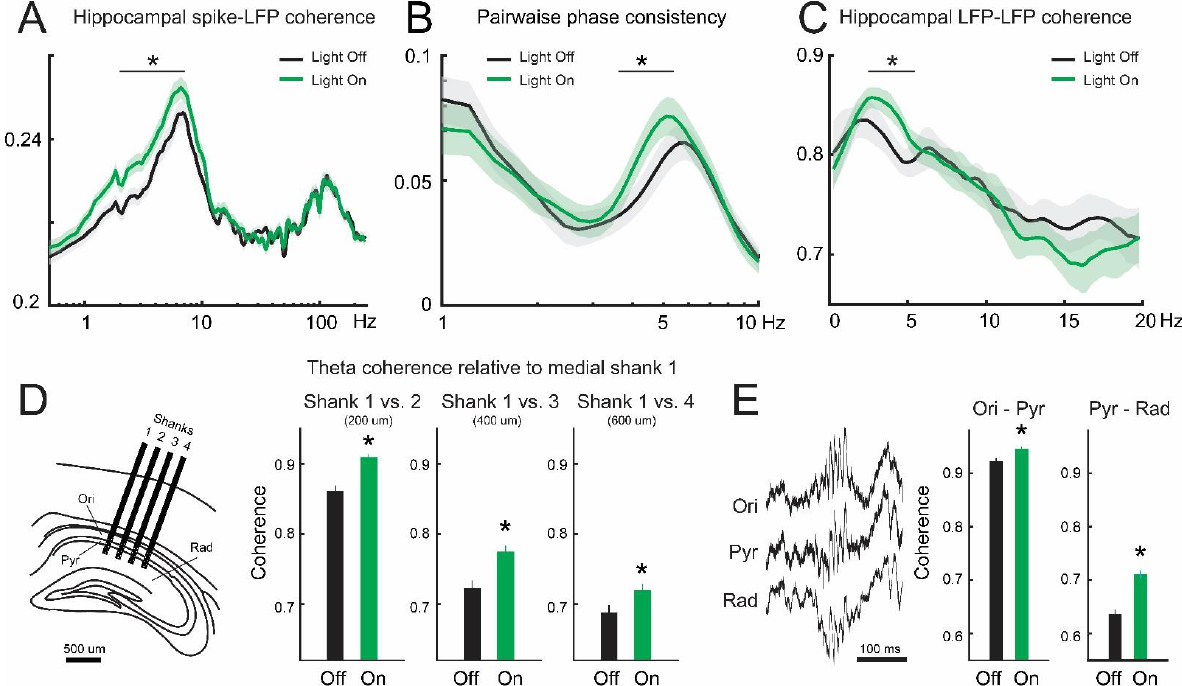
Figure 3. Intrahippocampal synchrony during optogenetic inhibition of septal somatostatin cells. ( A ) Average spike-field coherence between dorsal hippocampal units and LFP pyramidal layer before (off, black line, 5 s) and during light stimulation (on, green line, 5 s). Asterisk in band 2–7 Hz: * W = 16,976, p = 9.9 × 10 − 8 , Wilcoxon signed-rank test, n = 321 cells. ( B ) Average pairwise phase consistency (PPC) in the dorsal hippocampus. Wilcoxon signed-rank test in band 4–6 Hz. W = 21,510, * p = 0.0189, n = 321 cells. ( C ) Average LFP–LFP coherence around the pyramidal layer (i.e., be- tween the more dorsal and ventral channels of the shank). Asterisk in band 3–6 Hz: paired t -test, p = 0.00016, n = 27 recordings. ( D ) Statistically significant increase in hippocampal theta coherence across the medio-lateral axis, where magnitude is independent of the distance between shanks (two- way ANOVA, p < 10 − 6 ). ( E ) Example sharp-wave ripples recorded at different depths in the dorsal CA1 (left) and average LFP–LFP coherence around the pyramidal layer (right). The theta-promoting effect of septal stimulation was segregated between hippocampal layers, being more prominent between the stratum radiatum and pyramidal layer. Stratum oriens–stratum pyramidale coherence: Wilcoxon signed-rank test, W = 2904, * p = 2.24 × 10 − 5 , n = 140 trials. Stratum pyramidale–stratum radiatum: Wilcoxon signed-rank test, W = 1213, * p = 3.65 × 10 − 29 , n = 210